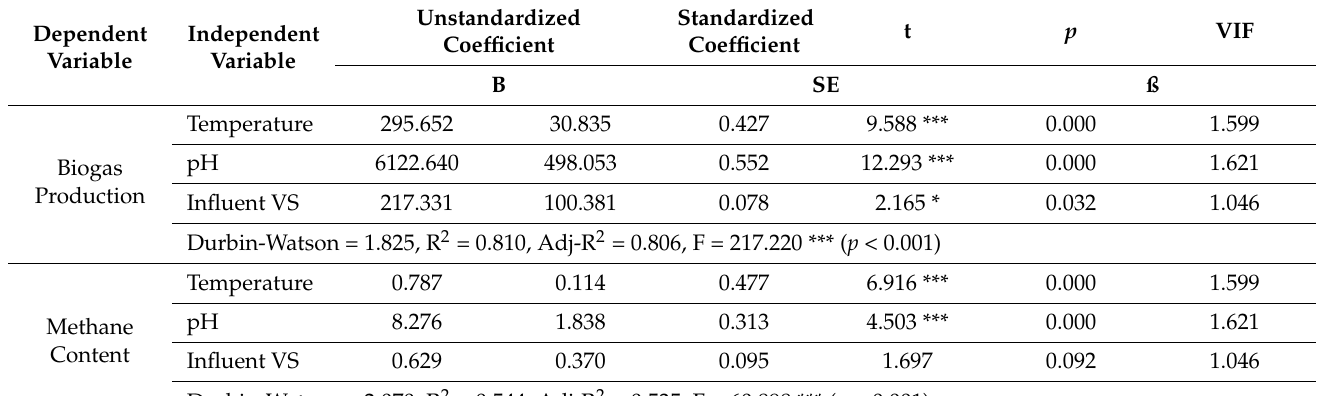
Table 9. The effects of temperature, pH, and influent VS on biogas production and methane